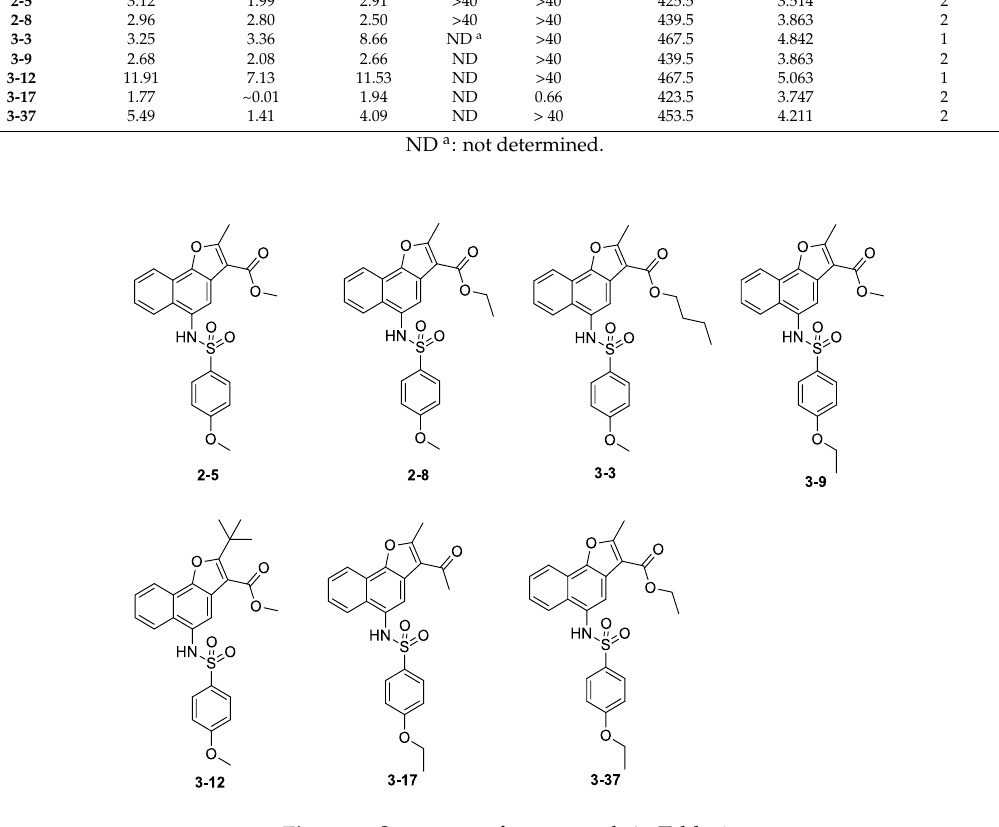
Figure 5. Structures of compounds in Table